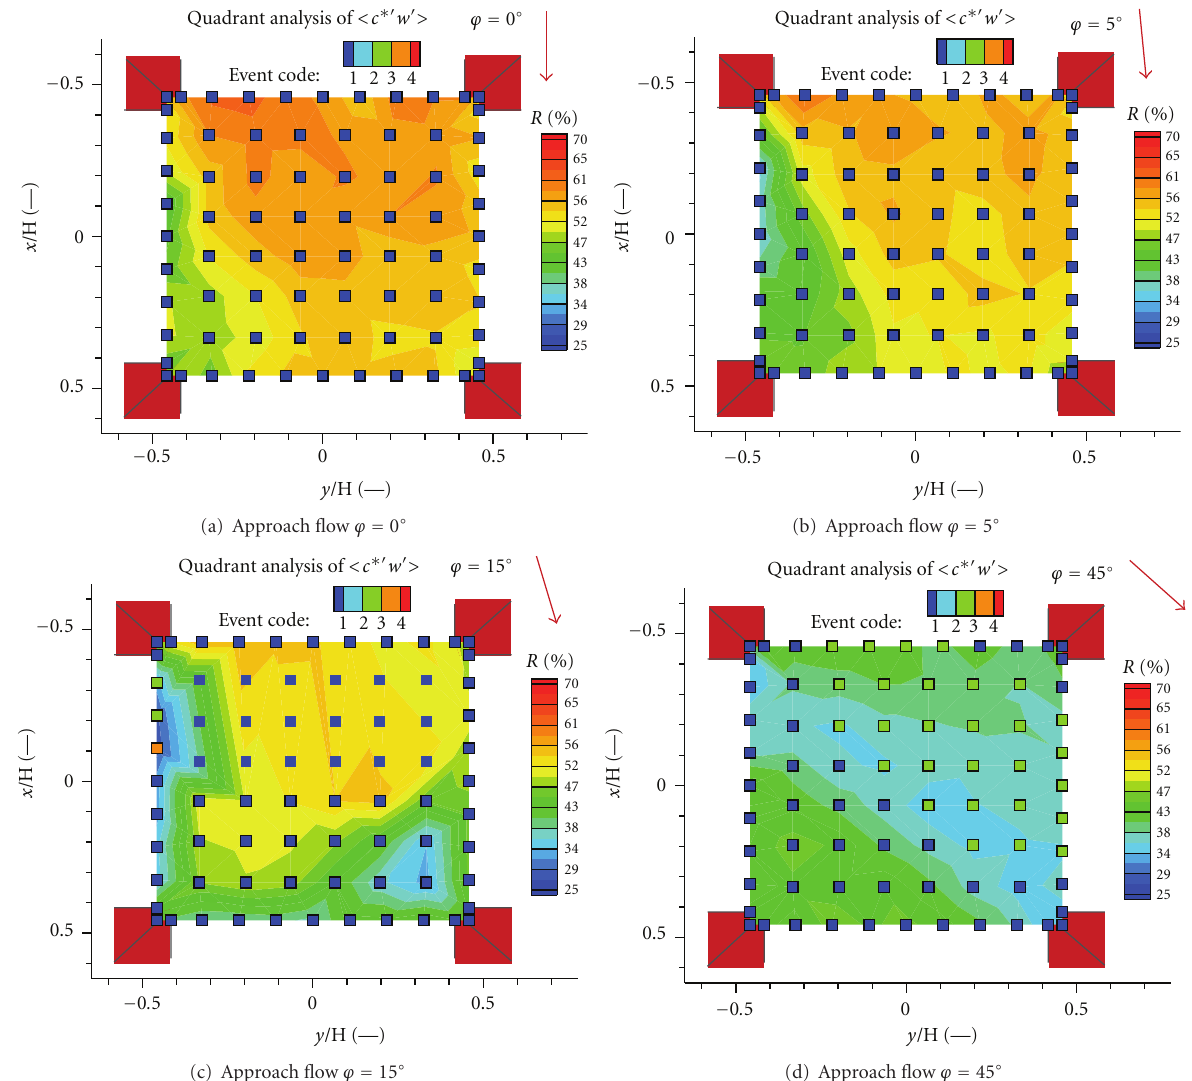
Figure 14: Relative contributions R of dominant event to the vertical turbulent scalar flux (cid:5) c ∗(cid:6) w (cid:6) (cid:7) /U 2 H for four angles of the approach flow